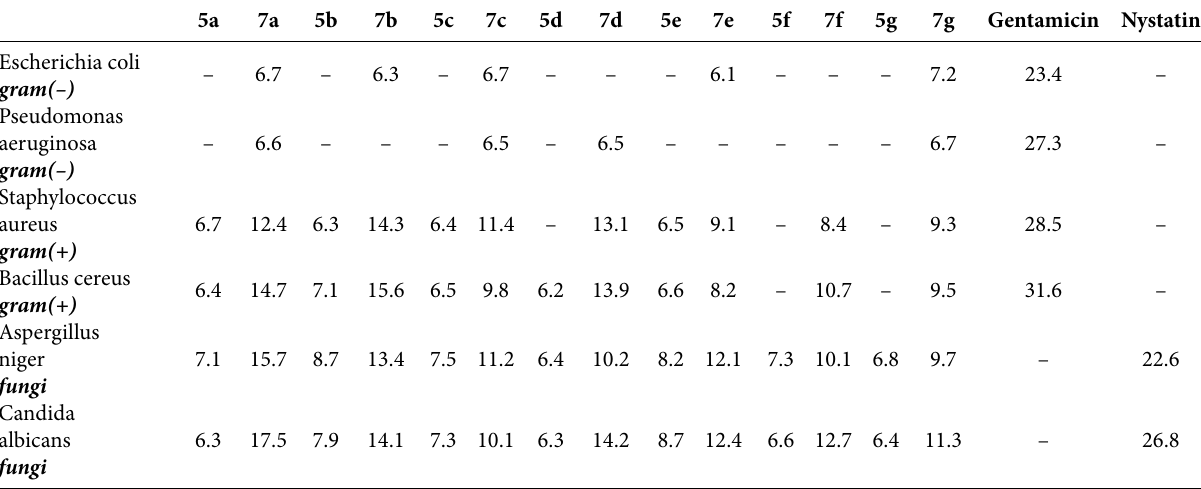
Table1. Diameter of inhibition zone (IZ) values of the compounds against 2 gram (+) bacteria, 2 gram (–) bacteria and 2 fungi